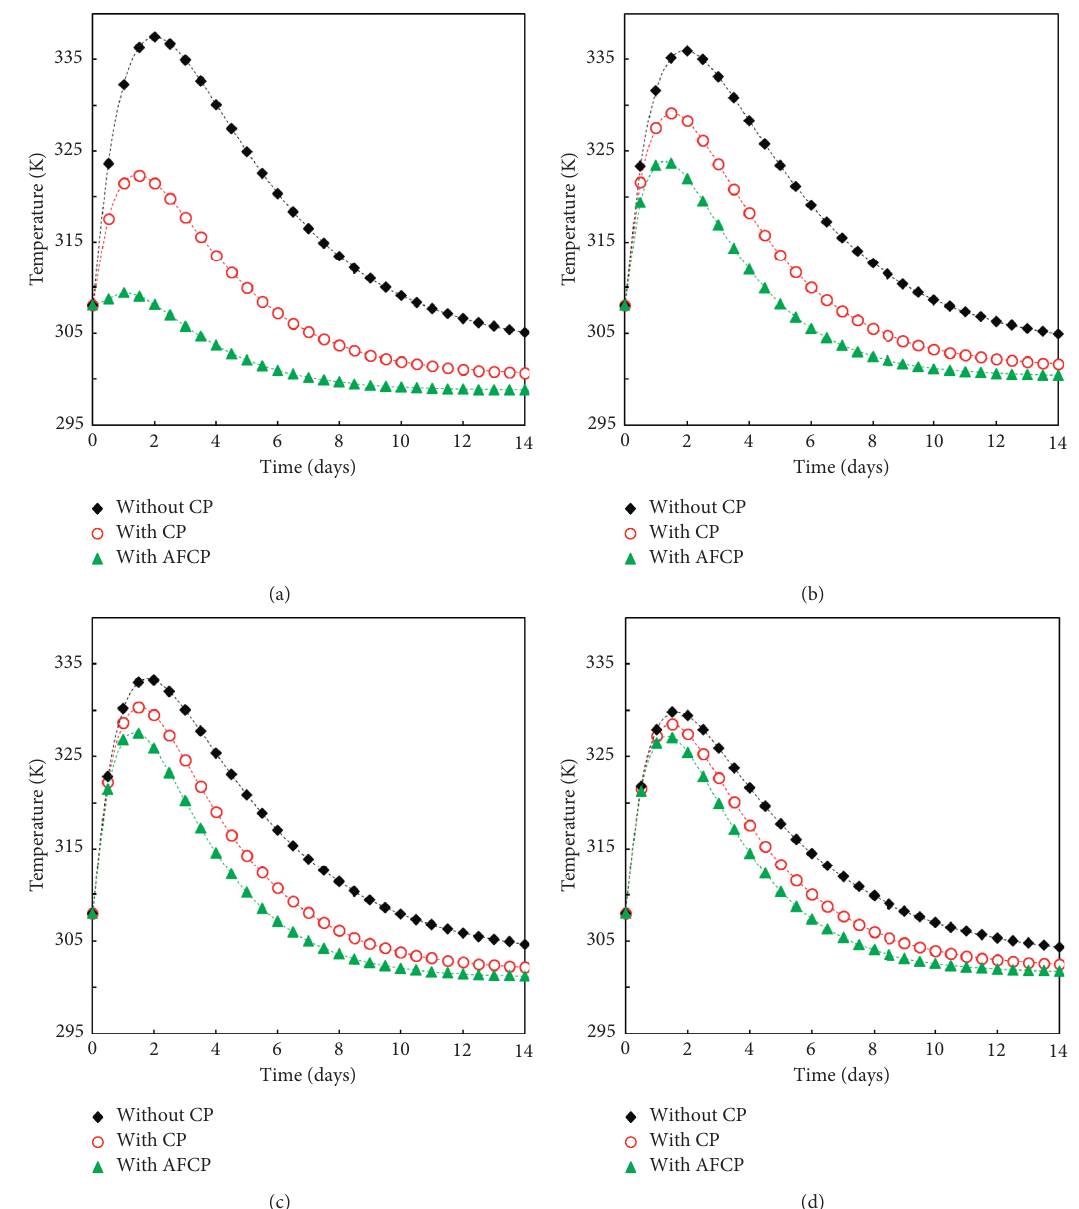
Figure 9: Temperature histories of the selected points: (a) point a ; (b) point b ; (c) point c ; (d) point d .